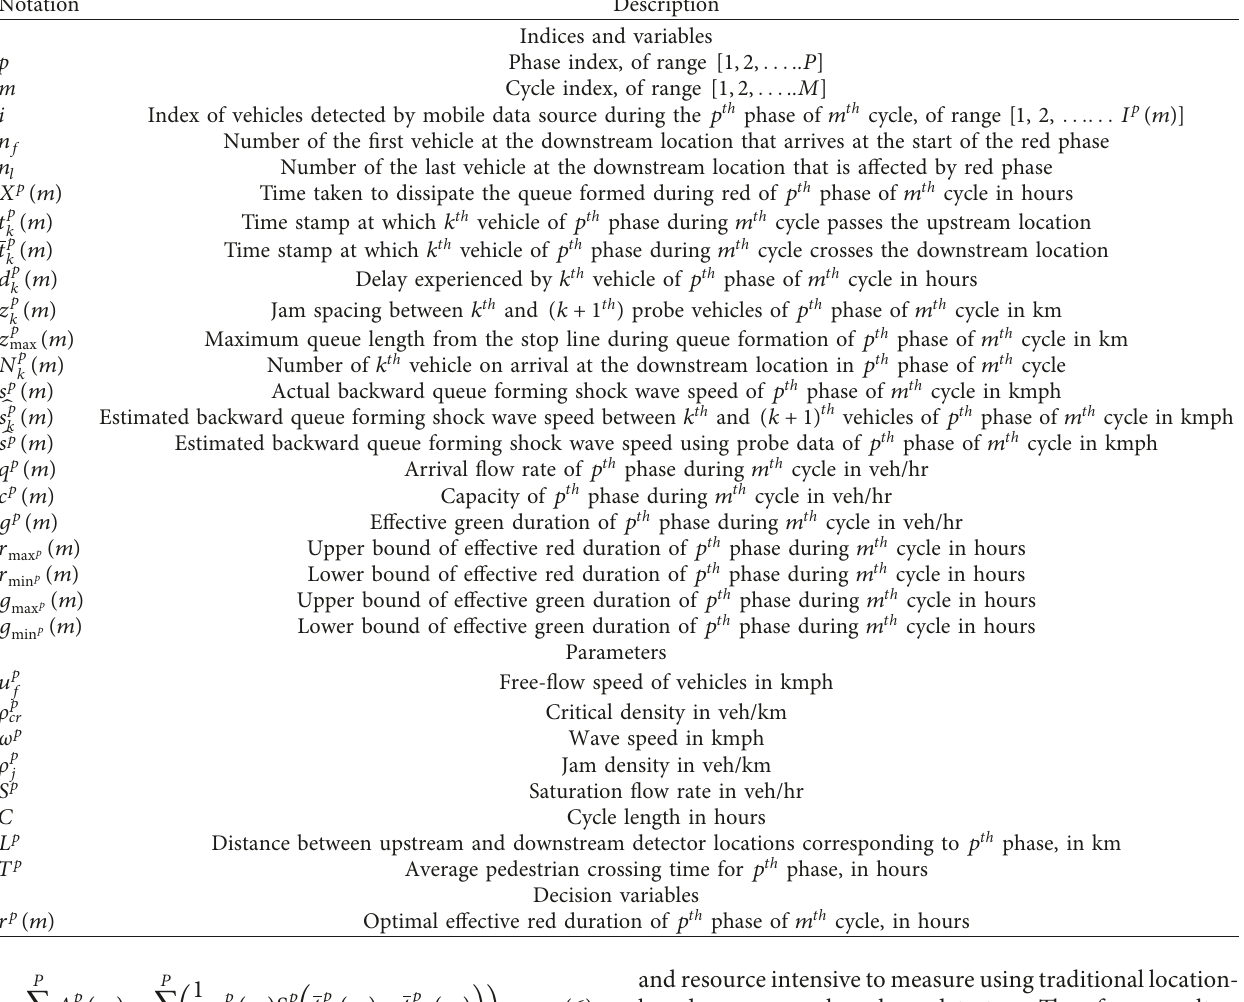
Table 1: List of